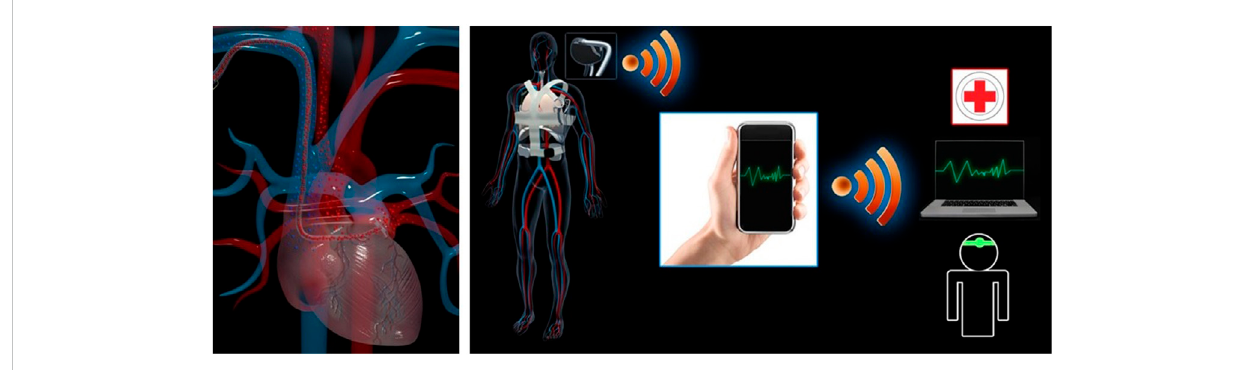
Healthy vs. diseased heart: beyond the therapeutic frontiers, VAD as transient therapeutic tool for heart recovery and/or possible gene therapy. Original author and copyright owner: MG